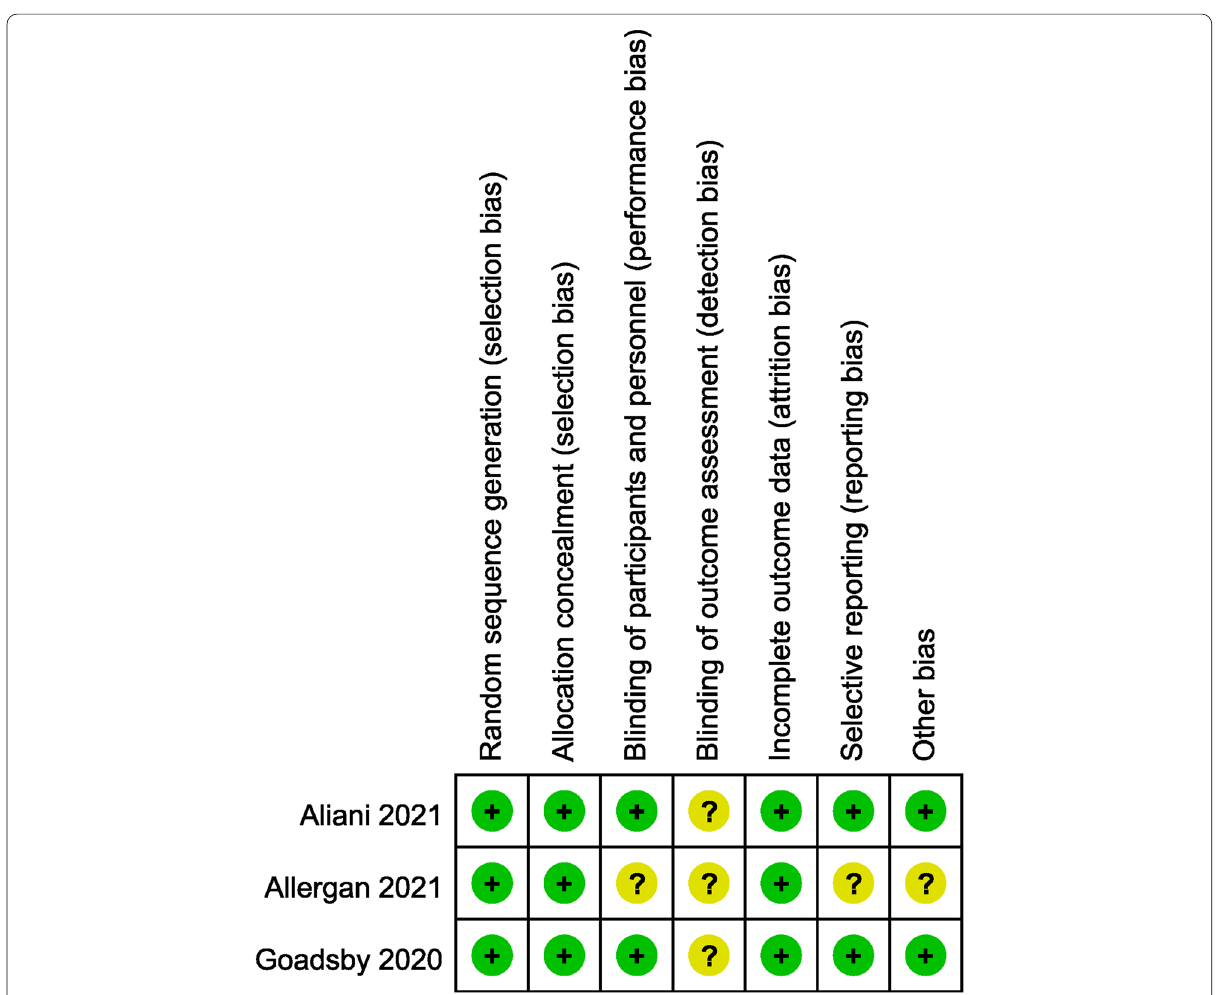
Fig. 7 Summary table for potential bias analysis for included